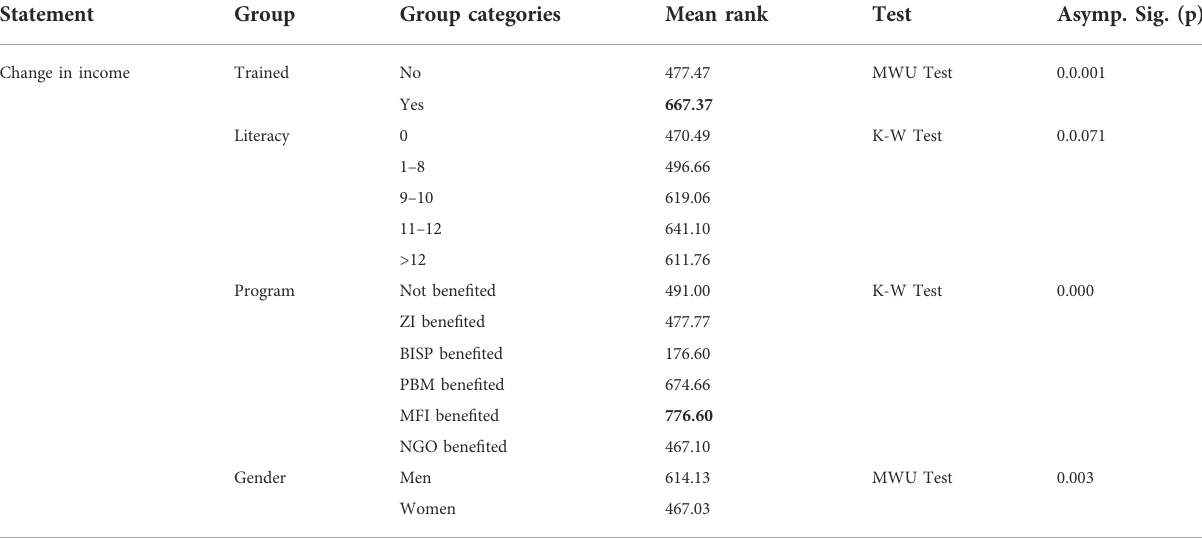
TABLE 3 Signi fi cance of training, literacy, program, and gender on the shift of income from the previous